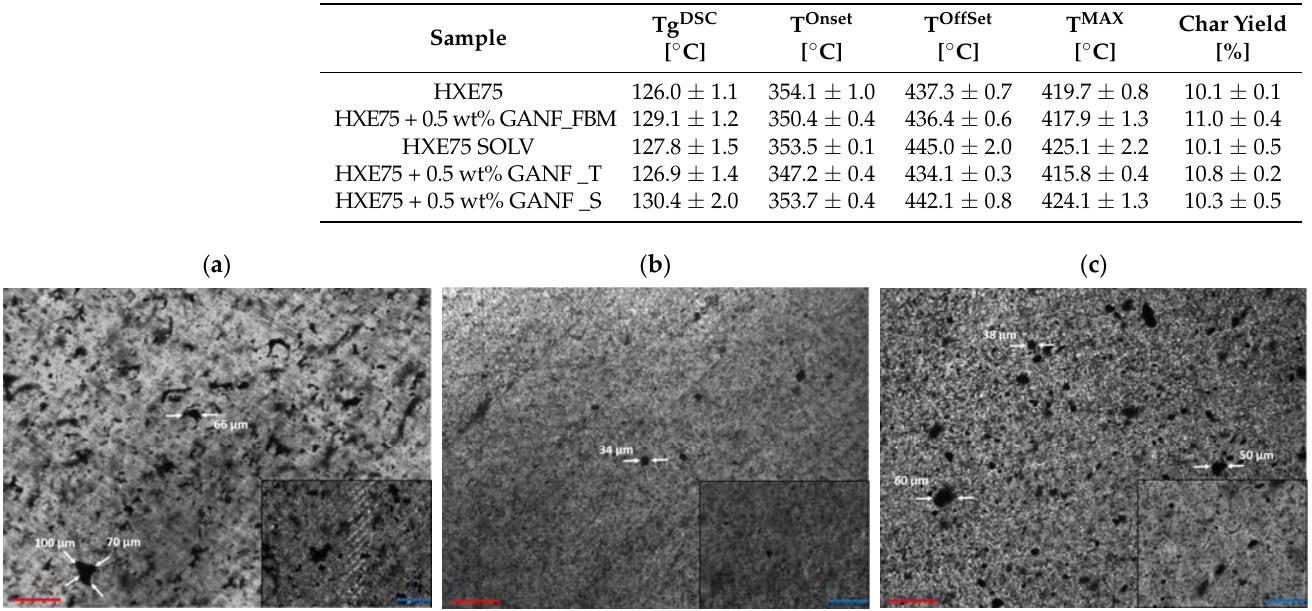
Figure 6. Optical microscopy (5x) of the GANF based nanocomposites (red scale bar: 200 μ m, blue scale bar: 100 µ m). ( a ) HXE75 + 0.5 wt% GANF_T. ( b ) HXE75 + 0.5 wt% GANF_S.